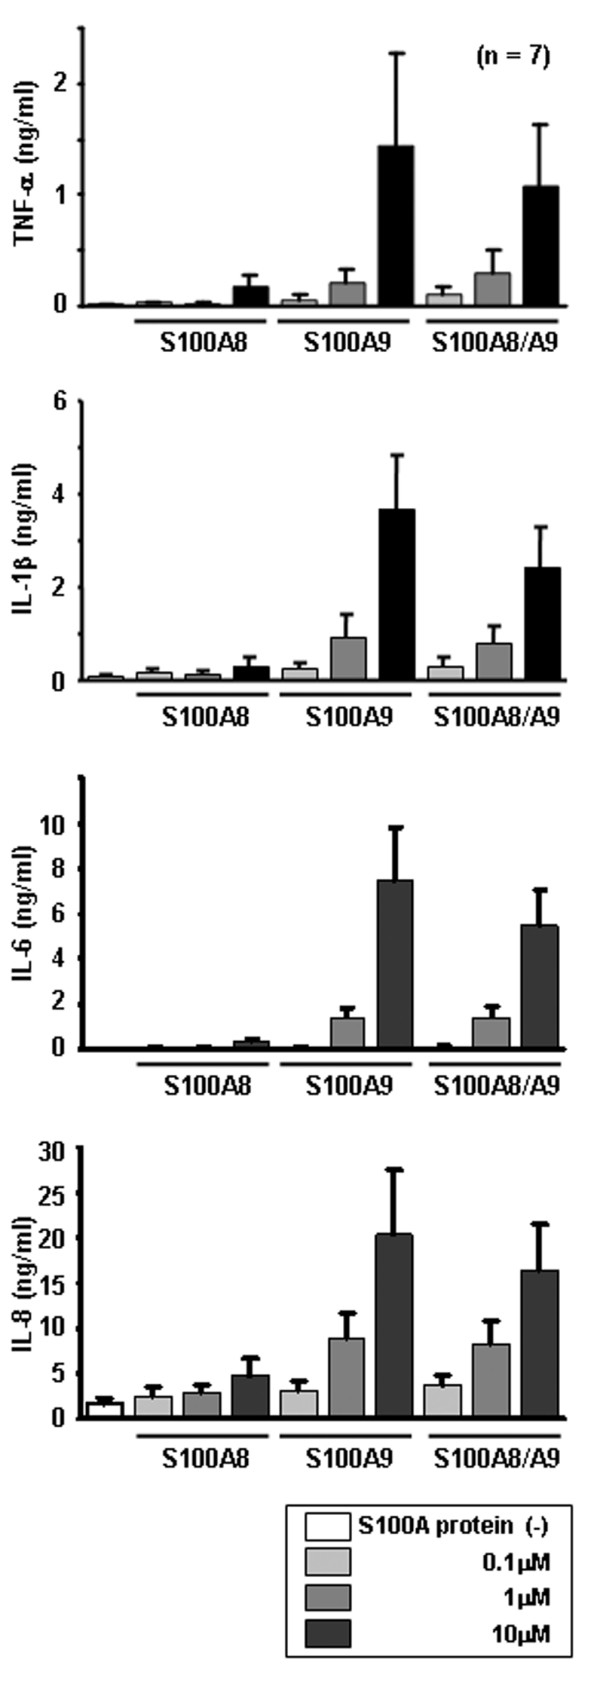
Induction of proinflammatory cytokine production by monocytes after stimulation with S100A8, S100A9, and S100A8/9. Monocytes were purified by negative selection from peripheral blood mononuclear cells of healthy individuals. The monocyte suspensions (1 × 106 cells per ml in culture medium with 10% fetal calf serum) were incubated with or without S100A8, S100A9, and S100A8/A9 (0.1–10 μM) in the presence of polymyxin B (100 μg/ml). Culture supernatants were harvested 24 hours later. Cytokine concentrations were measured by cytometric beads array (using anticytokine monoclonal antibody [mAb]-coated beads and phycoerythrin-conjugated anticytokine mAbs). Values are the mean ± standard error of the mean. IL, interleukin; n, number of samples tested; TNF-α, tumor necrosis factor alpha.